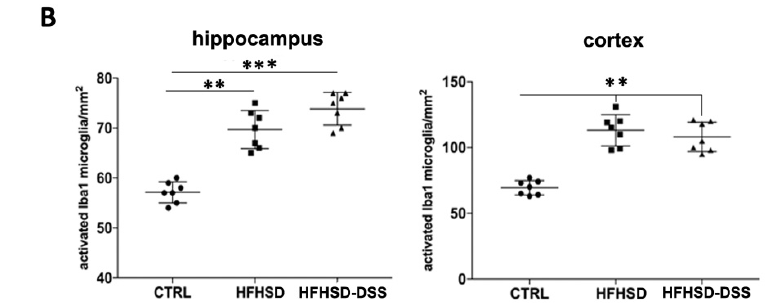
Figure 8. ( A ) Representative images of immunohistochemistry (IHC) staining of Iba-1 in different regions of the hippocampus and frontal cortex of treated mice as compared to control. 20 × magnification: Scale bar = 25 µ m. 4 × magnification: scale bar 100 µ m; ( B ) Quantitative analysis of stained nuclei/mm 2 . Each value is presented as the mean ± SD for seven mice. Statistical significance: ** p < 0.01; *** p < 0.001.